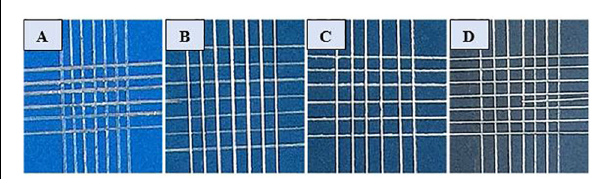
FIGURE 5 | Aspect of the samples submitted to the adhesion test of the coatings of neat e-coat (A) , e-coat/PPy 0.4% by weight (B) , 0.8% by weight (C) , 1.2% by weight (D)